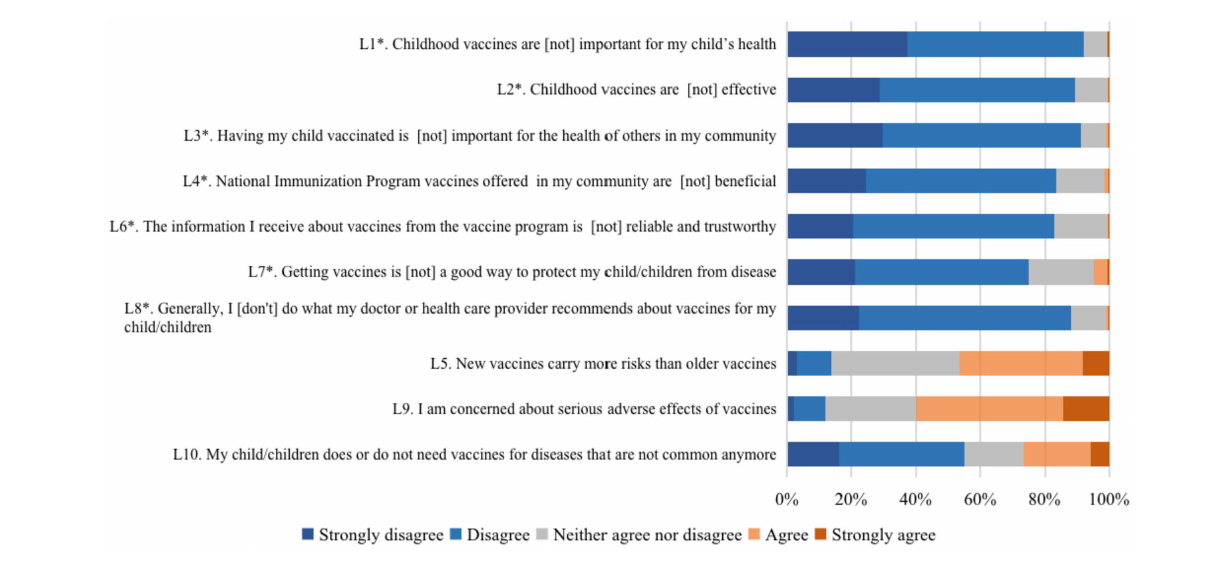
FIGURE 1 Distribution of responses to each item of the vaccine hesitancy scale. Items with a * were reverse